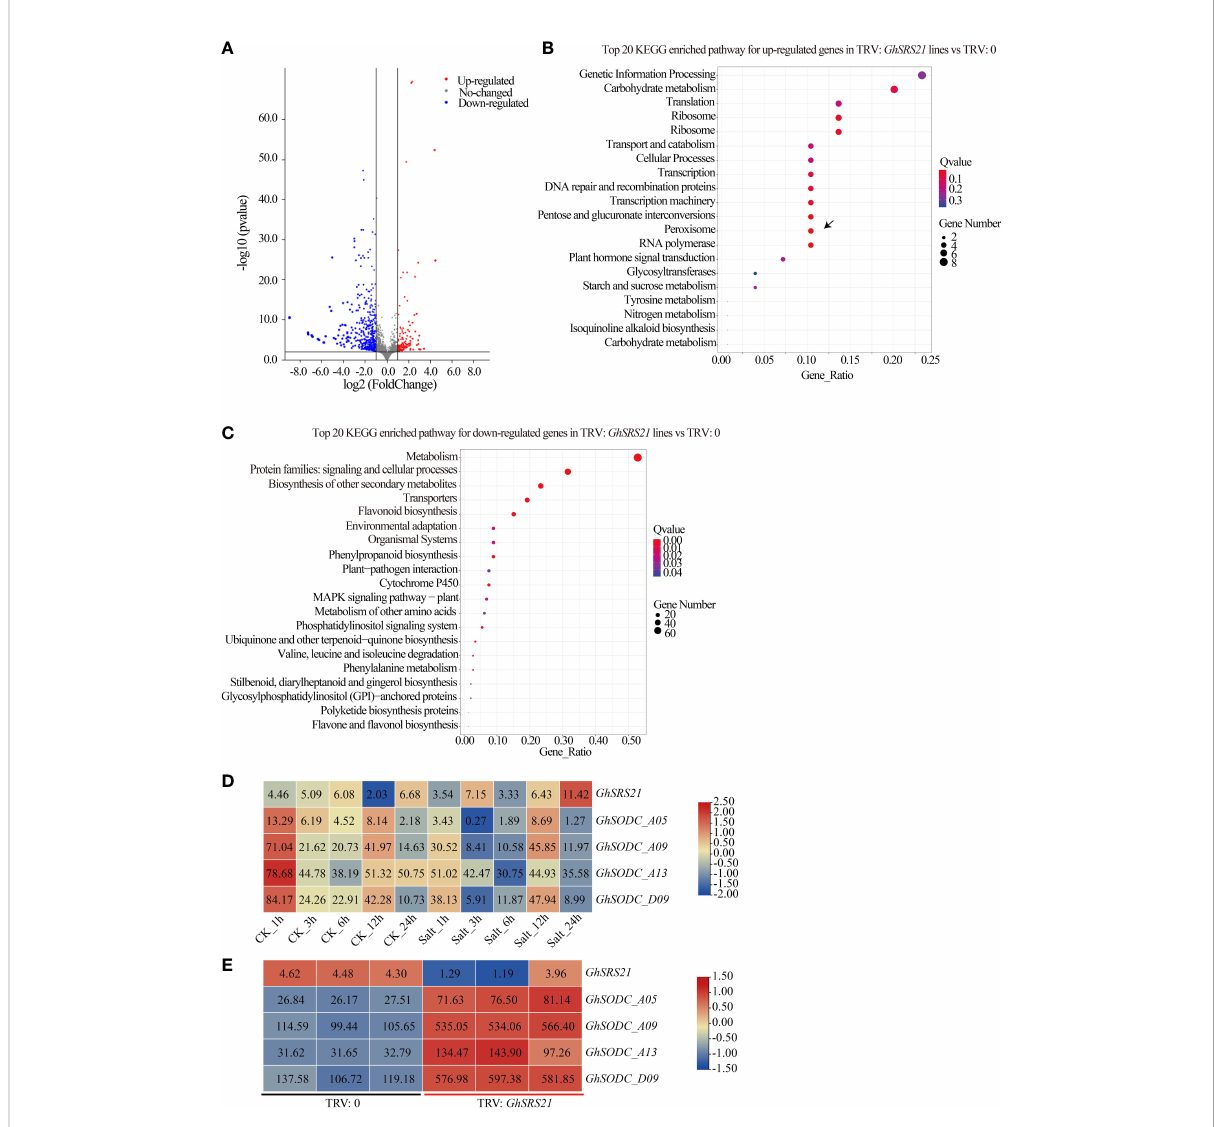
FIGURE 8 Transcriptome analysis of GhSRS21 VIGS lines. (A) Volcano map of DEGs ( GhSRS21 VIGS lines vs negative control). (B, C) KEGG pathway analysis for up-regulated genes and down-regulated genes in GhSRS21 VIGS lines vs negative control (TRV: GhSRS21 lines represent the GhSRS21 VIGS lines and TRV: 0 represent the negative control), respectively. (D) Expression pattern of GhSRS21 and SODCs under control and salt treatment. (E) Expression pattern of GhSRS21 and SODCs in GhSRS21 VIGS lines vs negative control. Heatmap in (D, E) was normalized by the average log 2 of FPKM values and the numbers in rectangle indicate FPKM